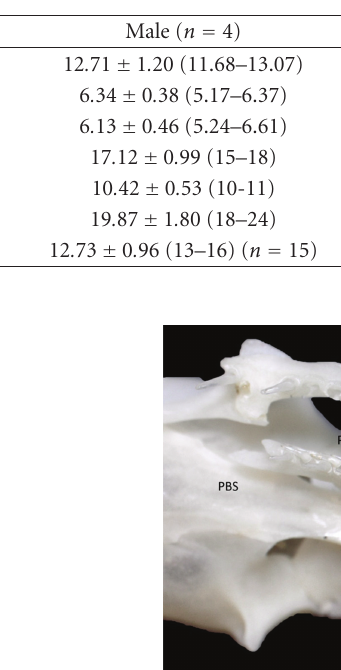
Table 2: Meristic and morphometric variation of the skull of Sordellina punctata . Data expressed by mean ± standard deviation (amplitude).